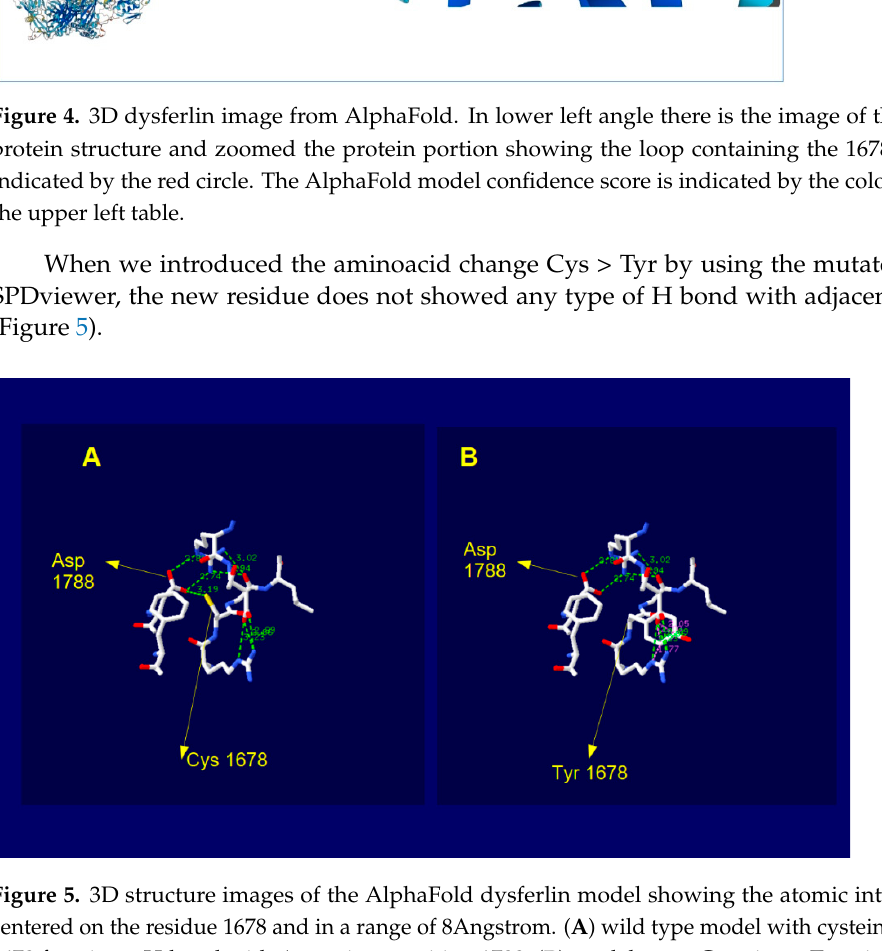
Table 3. Energy values (KJ/mole) of Wild type (Wt) and mutated dysferlin .